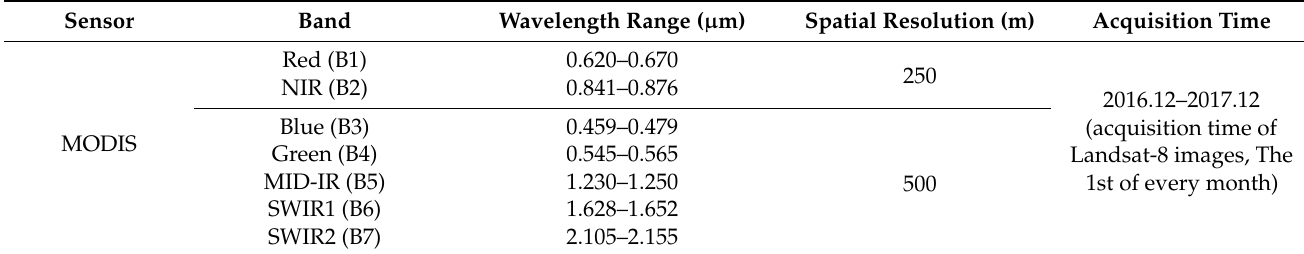
Table 2. Spectral bands and acquisition dates of Landsat-8 OLI in the study.